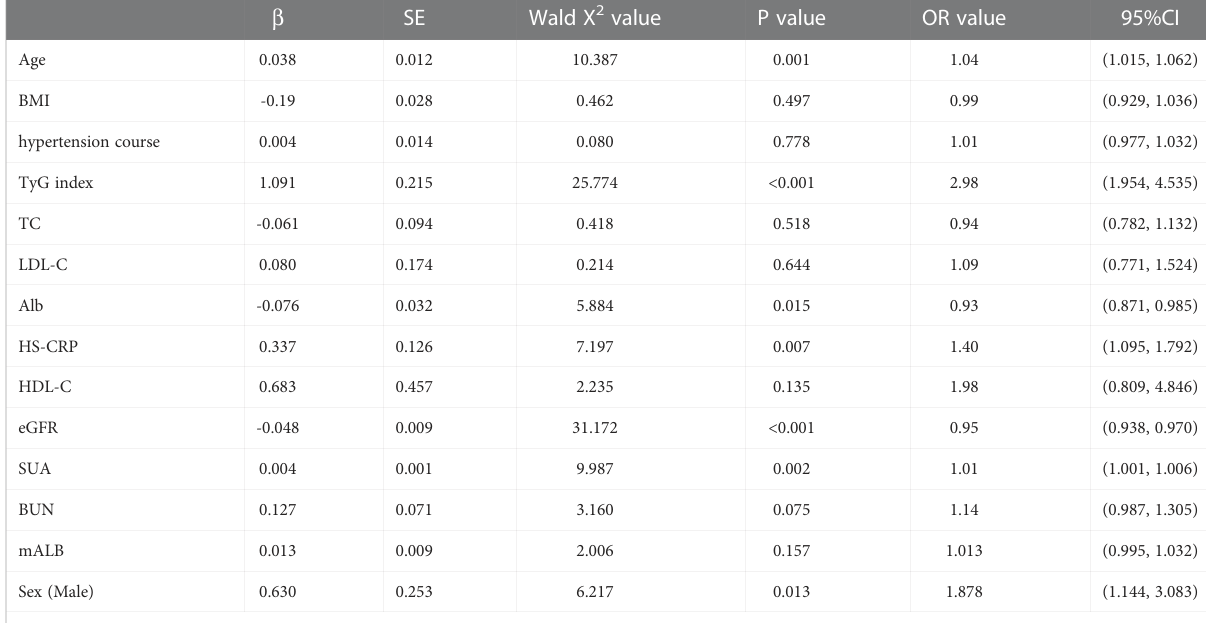
TABLE 6 Multivariate Logistic regression analysis of early renal impairment (CysC>1.25mg/L) in hypertensive patients.